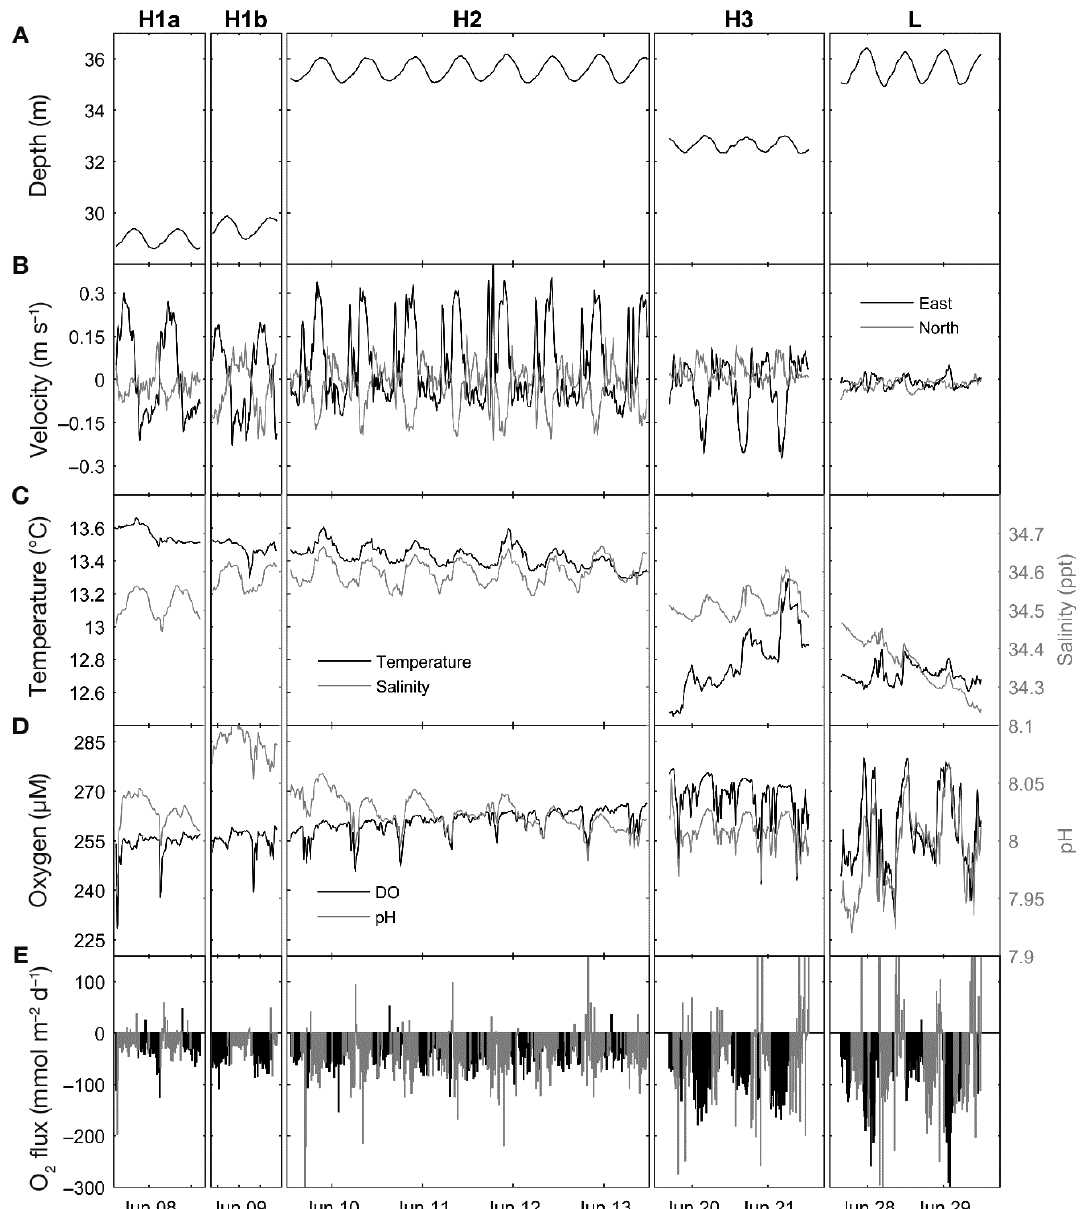
Fig. 3. Burst-averaged values of (A) water depth, (B) east and north water velocity, (C) water temperature and salinity, (D) dis- solved oxygen and pH and (E) oxygen flux (negative values indicating a downward flux and unreliable fluxes shown in